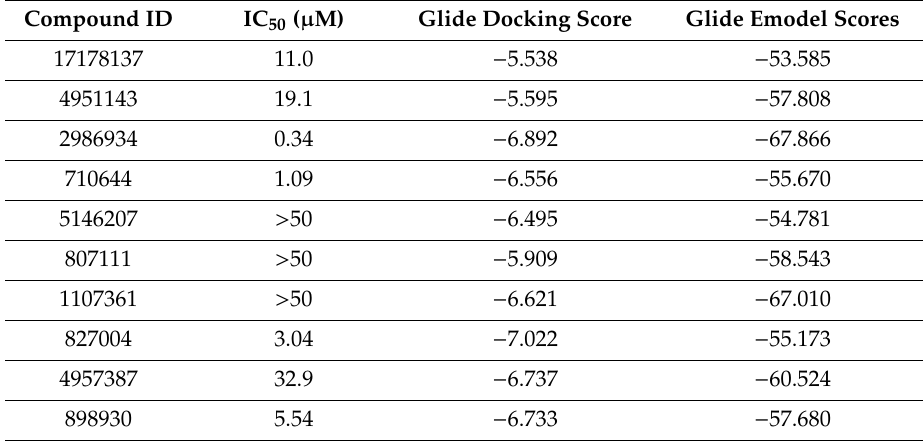
Table 8. Biological data, docking scores and emodel scores of selected non-amidine literature inhibitors (Chen et al.,